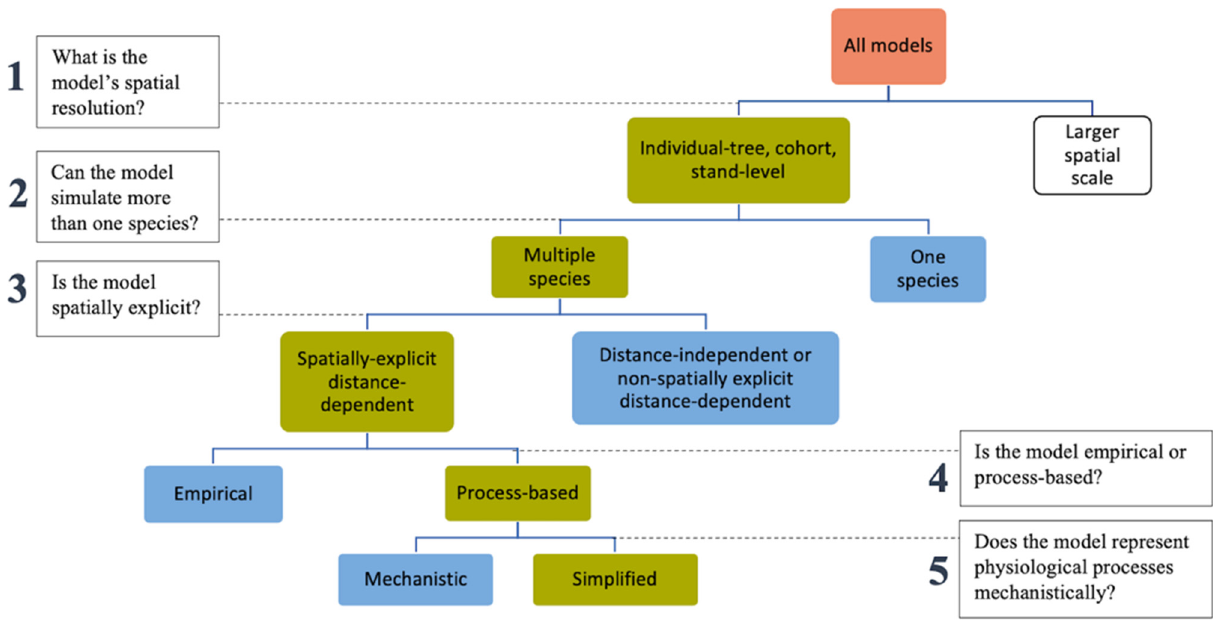
Figure 2. Tiered series of evaluation criteria used to assess the suitability of 54 forest dynamics models for informing small forest management concerns. Characteristics that are more relevant and appropriate for small forests are in green. Characteristics with weaker relevance, or narrow applicability to specific management concerns, are in blue. Characteristics that will not help inform small forest management are in